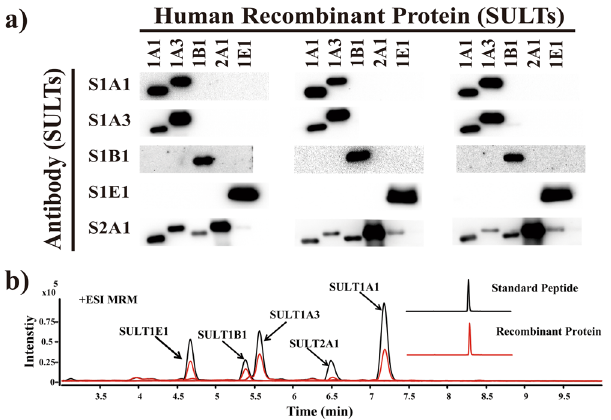
Figure 1. ( a ) SULT enzyme antibodies were used to analyze human recombinant proteins including SULT1A1, SULT1A3, SULT1B1, SULT1E1 and SULT2A1. The same experiments were repeated three times. ( b ) The black peak represents the MRM chromatograms of the tryptic peptides derived from healthy human liver S9 samples, and the chromatograms of the five tryptic peptides were detected through quantitative MRM transitions. The red peak represents the MRM chromatograms of SULT human recombinant